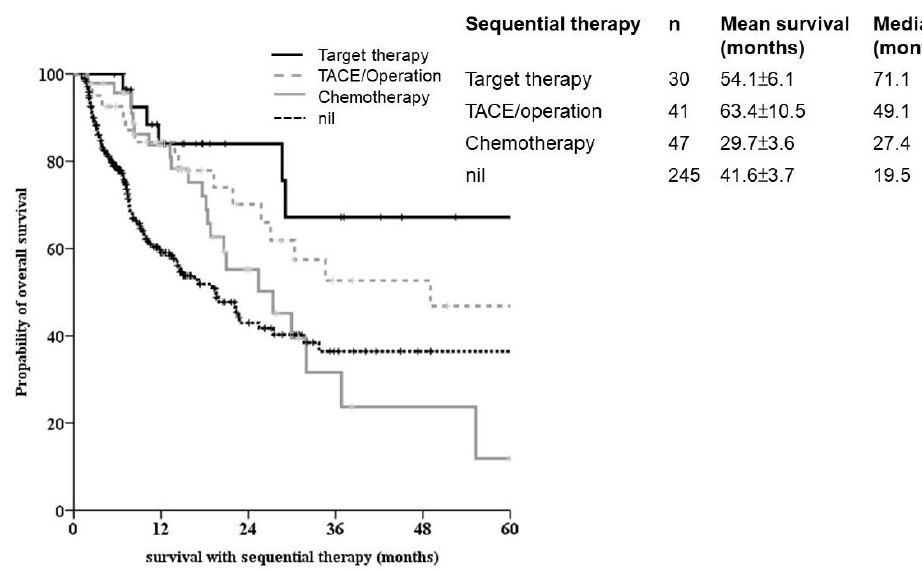
Figure 4. Sequential therapy for advanced HCC. Kaplan-Meier survival analysis showed significantly better outcomes in the tyrosine kinase inhibitor group (solid line). Patients with chemotherapy-based second line-treatment for aHCC showed significantly poorer outcomes.